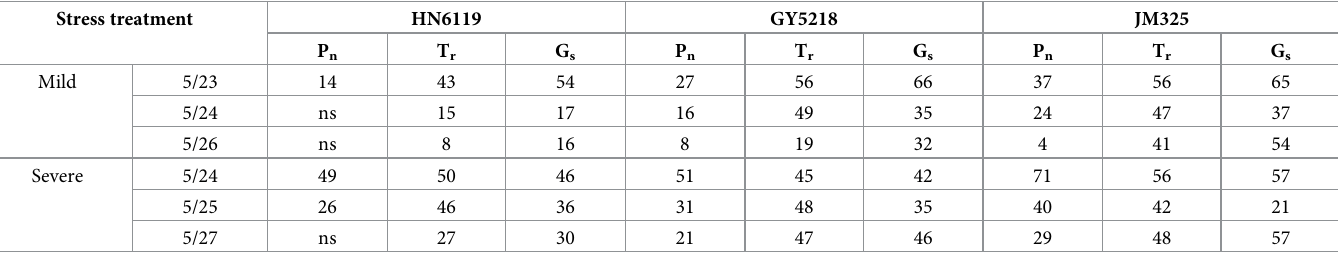
Table 6. SI (unit: %) of the different photosynthetic physiological parameters for the three cultivars after DHW stress during the 2020 experiment. Stress